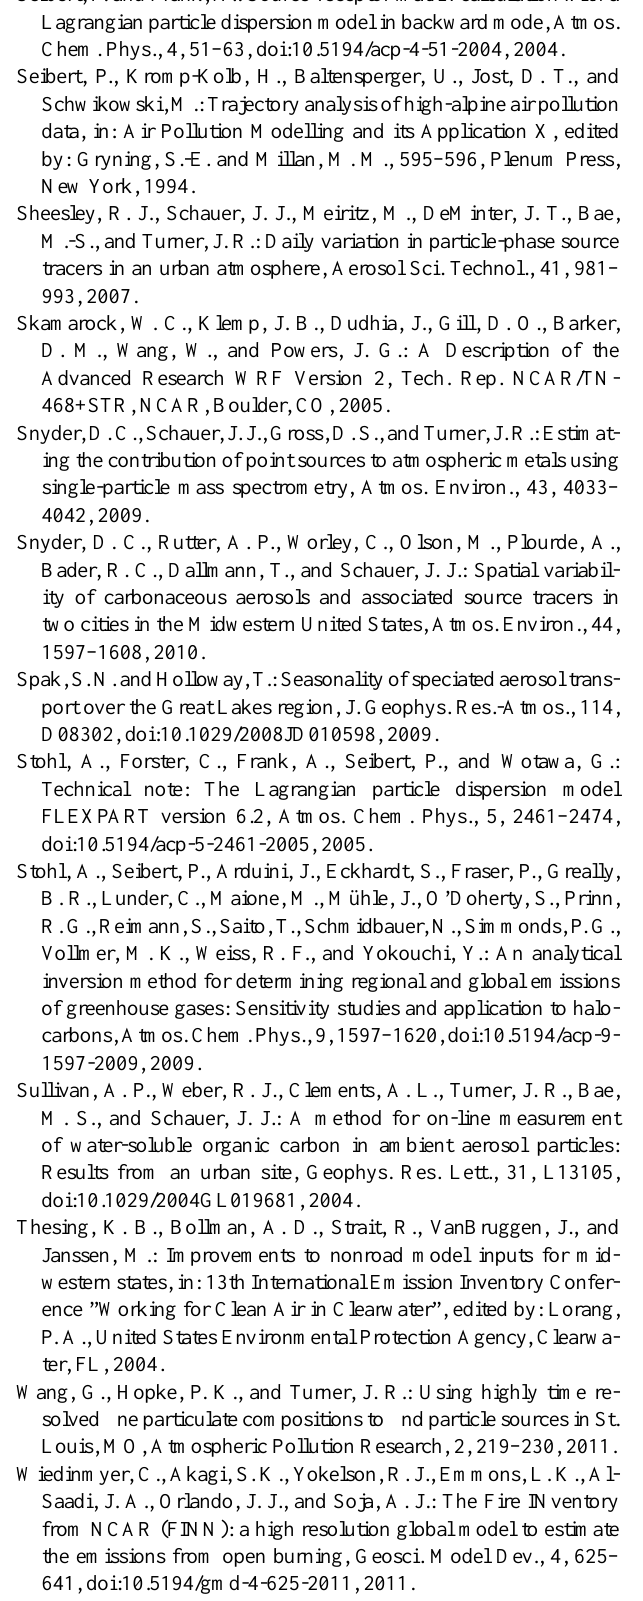
LADCO: Regional Air Quality Analyses for Ozone, PM 2 . 5 ,